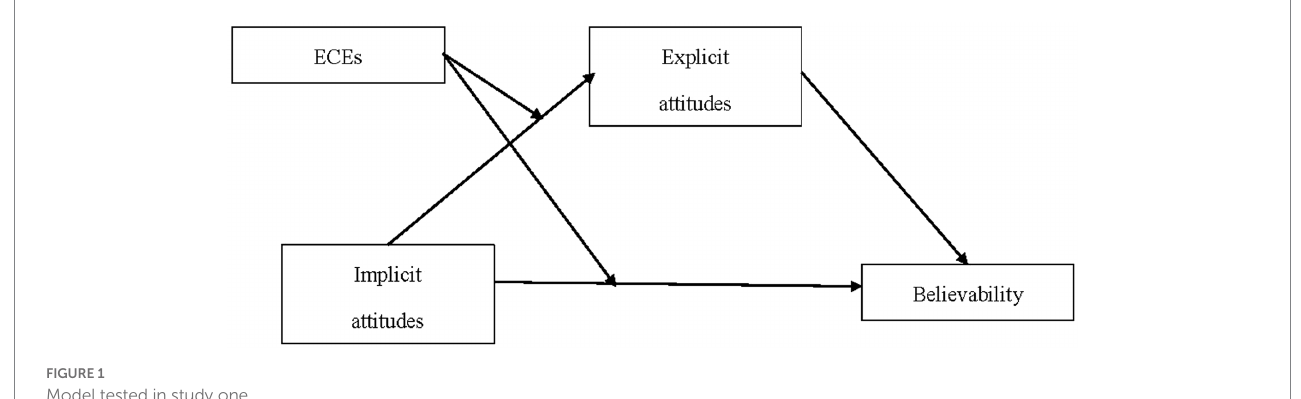
FIGURE 1 Model tested in study one.